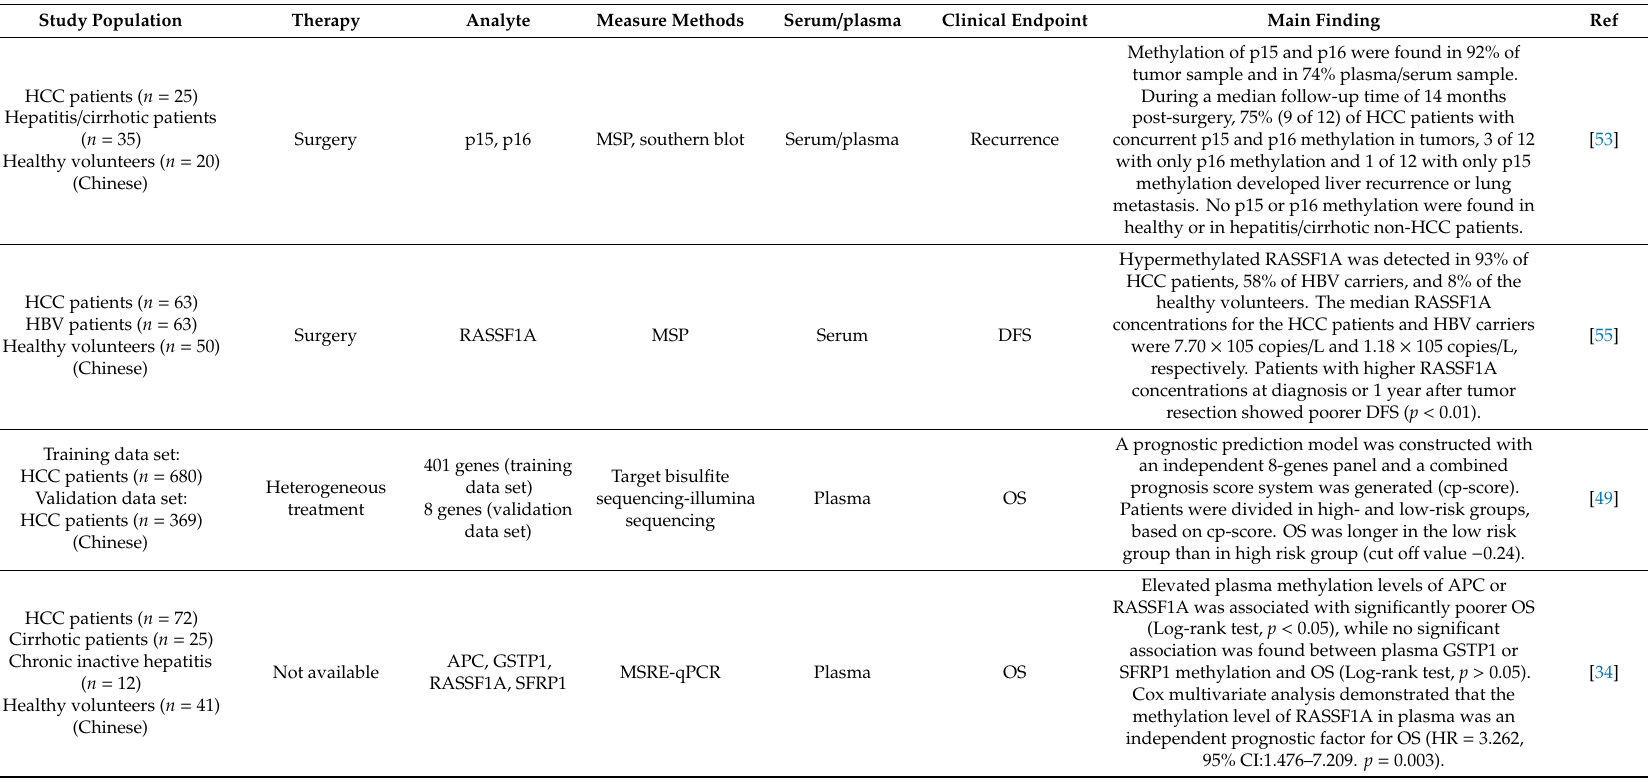
Table 3. Methylation profile of circulating tumor DNA (ctDNA) and therapy outcome in hepatocellular carcinoma (HCC) patients. Study Population Therapy Analyte Measure Methods Serum / plasma Clinical Endpoint Main Finding Ref